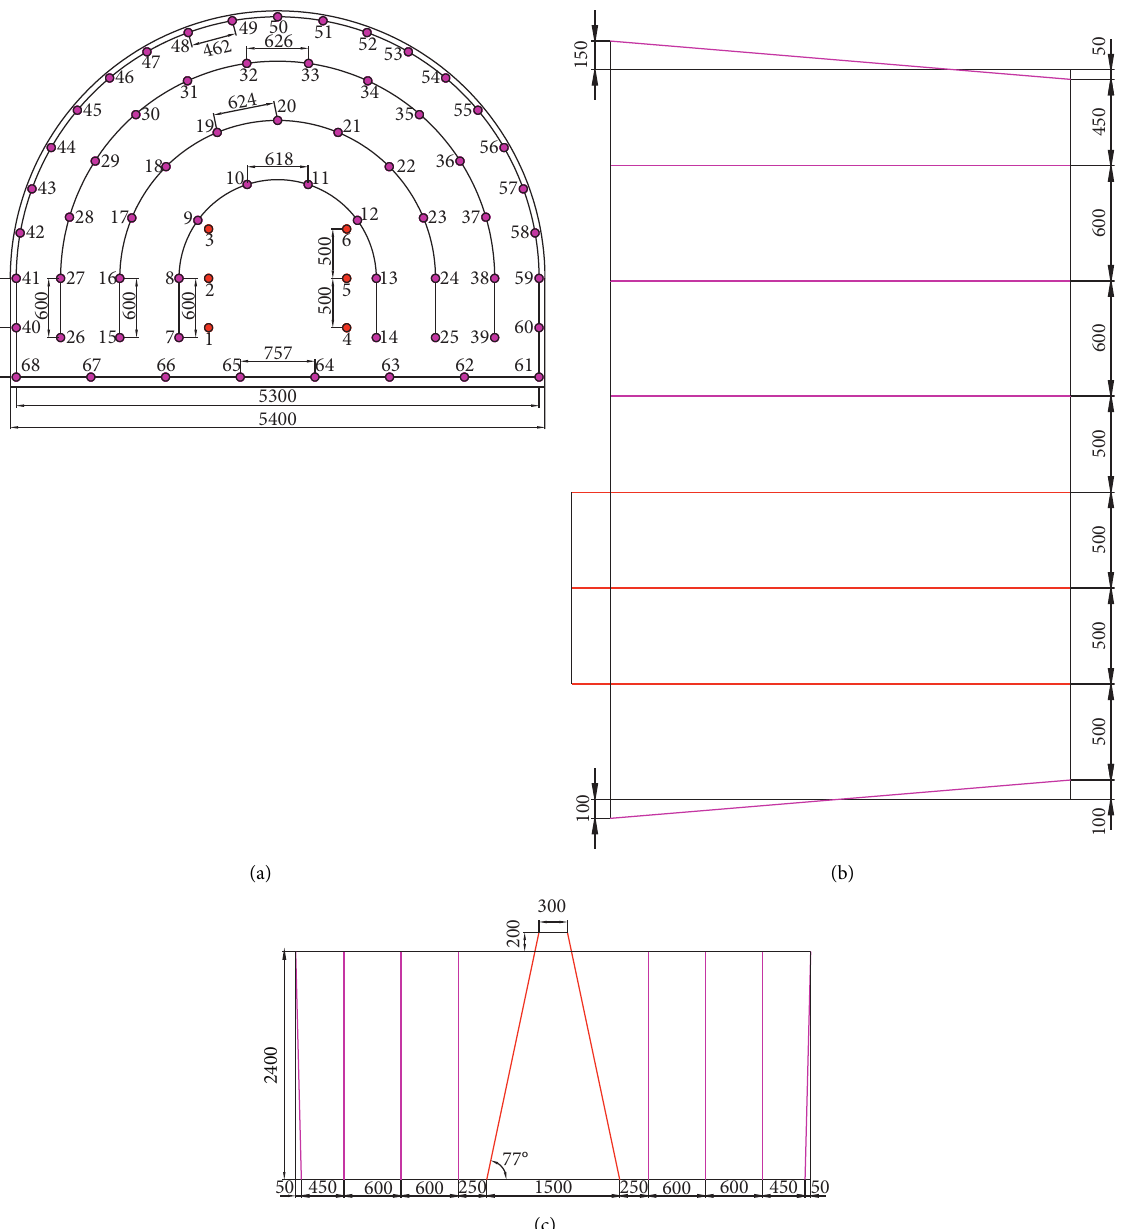
Figure 8: Blast hole layout (unit: mm). (a) Front view. (b) Left view. (c) Top